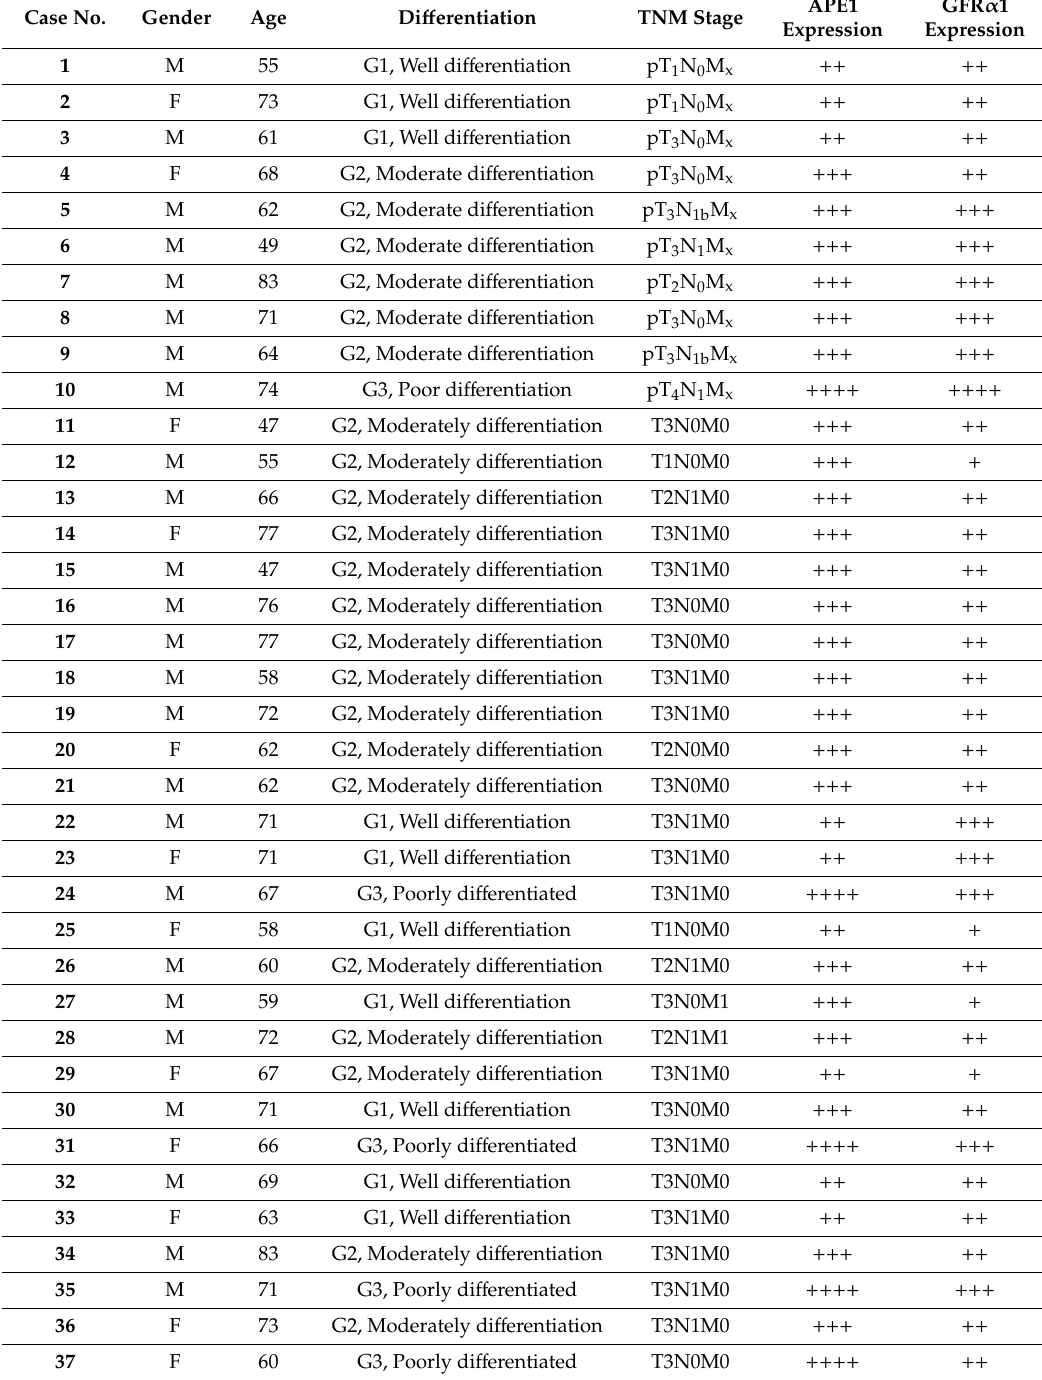
Table 1. Relative expressions of APE1 and GFR α 1 in pancreatic cancer